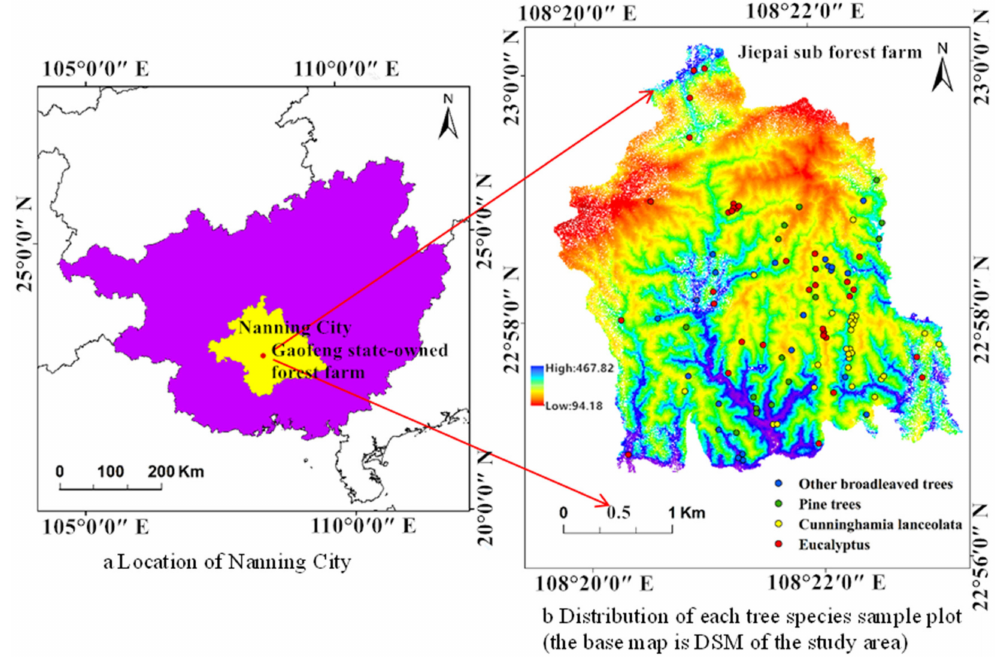
Figure 1. Location of the study area ( a ) is the location of Nanning City. ( b ) is the distribution of each tree species sample